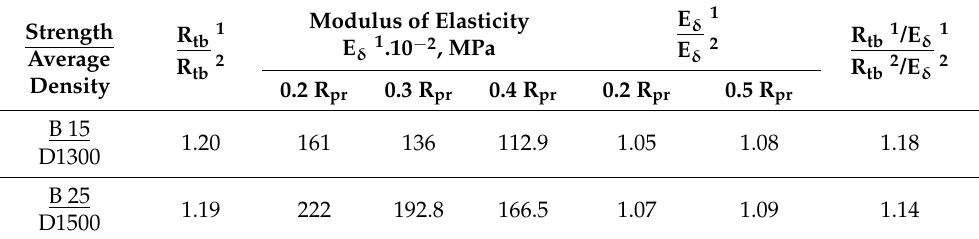
Table 9. Comparative study of strength and deformation characteristics of lightweight concrete on SSB and CEM 32.5.